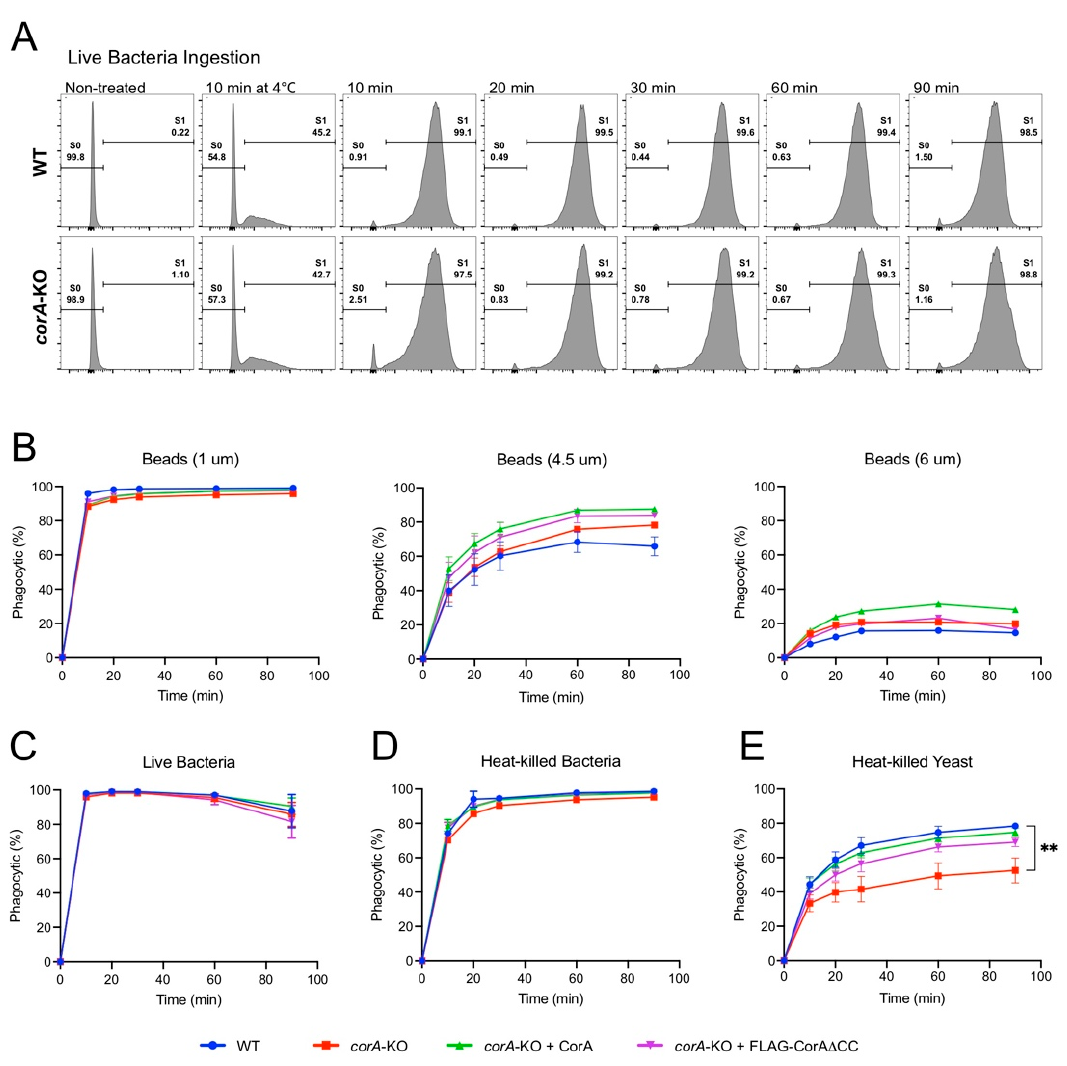
Figure 6. Phagocytosis in the presence and absence of coronin A. ( A ): Histogram profiles of the distribution and percentage of wild type and corA − cells that have phagocytosed (S1) live E. coli after different time points of incubation. Incubation at 4 °C (control) showed significant reduction of phagocytosis. Shown are representative results from at least 3 independent experiments. ( B – E ): Plot of the percentage of wild type, corA − , corA − + CorA, corA − + FLAG-CorA and corA − + FLAG-CorA ∆ CC DH1-10 cells that have taken up beads of the indicated sizes ( B ) live E. coli ( C ), heat-killed bacteria ( D ), or heat-killed yeast ( E ), respectively (error bar = standard error; ** p < 0.002).